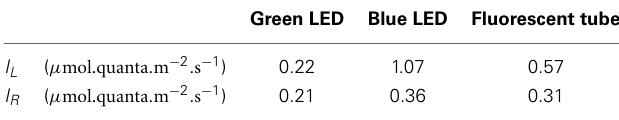
Table 3 | Best-fitting set of intensities I L (resp., I R ) perceived by LOV-HK (resp., Rhod-HK) for various sources of